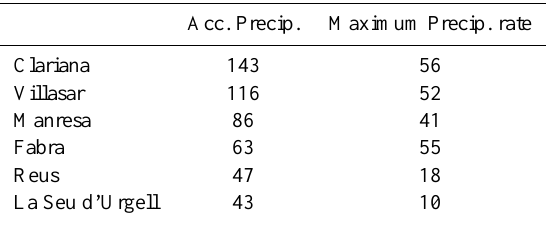
Table 2. Average values of the observed precipitation for 14 September 1999. The exact position of the rain gauge stations is shown in Fig. 3.